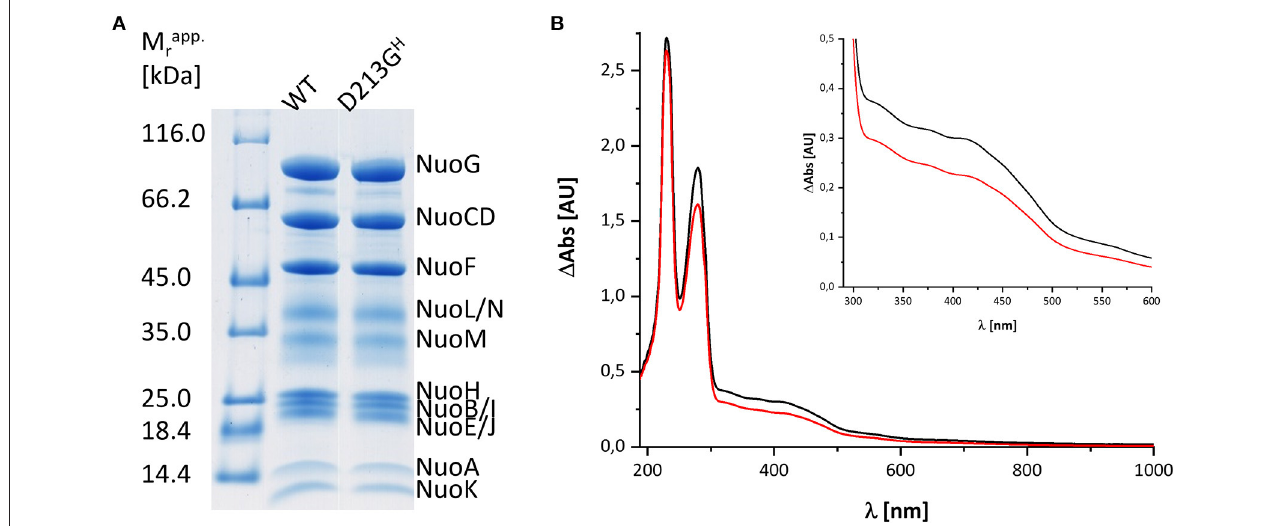
FIGURE 1 | Characterization of the preparations used in this study. (A) SDS-PAGE of the preparations of wild type (WT) and the D213G H variant. The bands are attributed to individual subunits according to their apparent molecular mass. The left lane shows the bands of the marker with the individual masses in kDa. (B) UV-vis spectra of the preparations of the wild type (black) and the D213G H variant (red). The inset shows the spectral region with the absorbance of the cofactors with a magnified